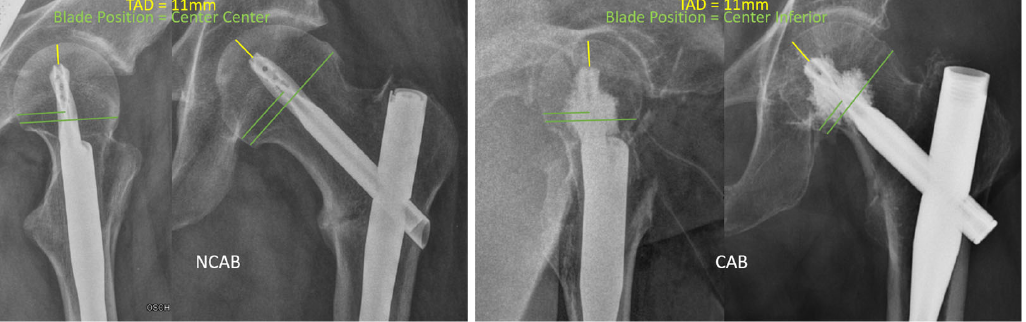
Table 1. Patient demographics.